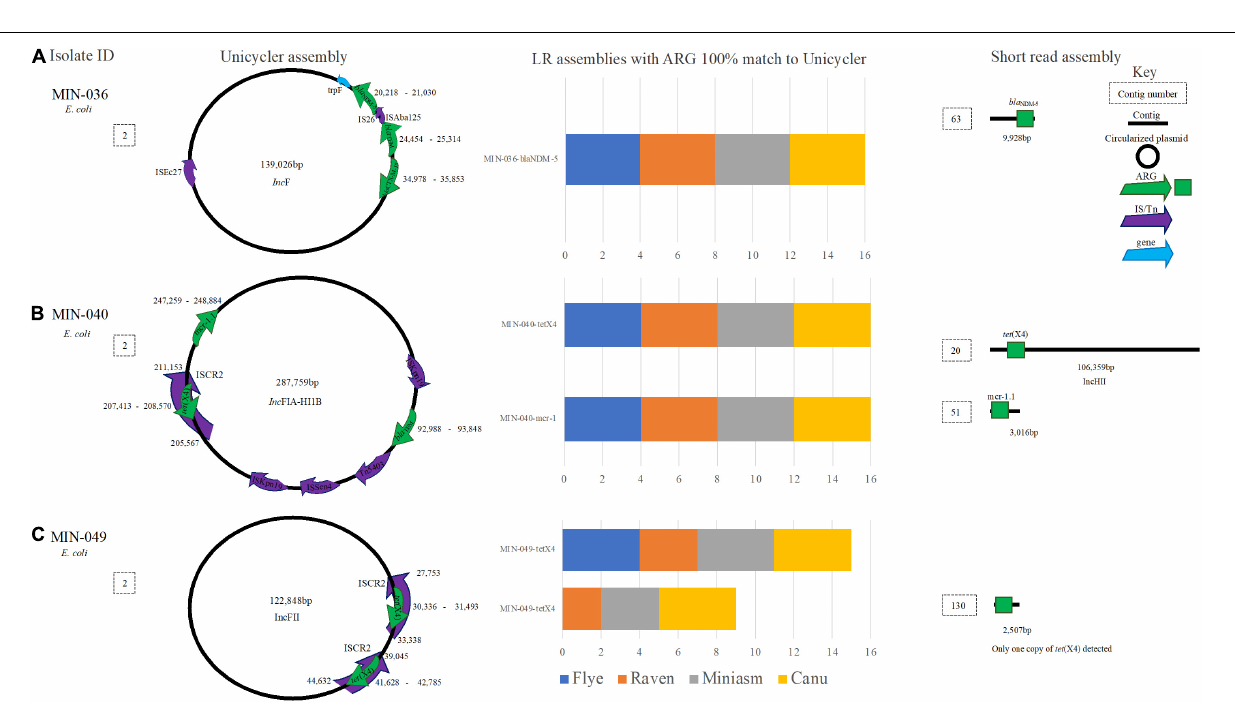
FIGURE 7 | A schematic to compare E. coli ARG detection from the Unicycler (hybrid) assembly (left), with the short read (SR) assembly (right). The stacked bar graphs (center) denote the number of LR assemblies with a 100% match to the Unicycler assembly, (A) MIN-036 with bla NDM − 5 , bla TEM , and bla CTX − M − 15 on the same plasmid, (B) MIN-040 with tet(X4),mcr-1.1 and bla TEM on the same plasmid, (C) MIN-049 a plasmid with two copies of